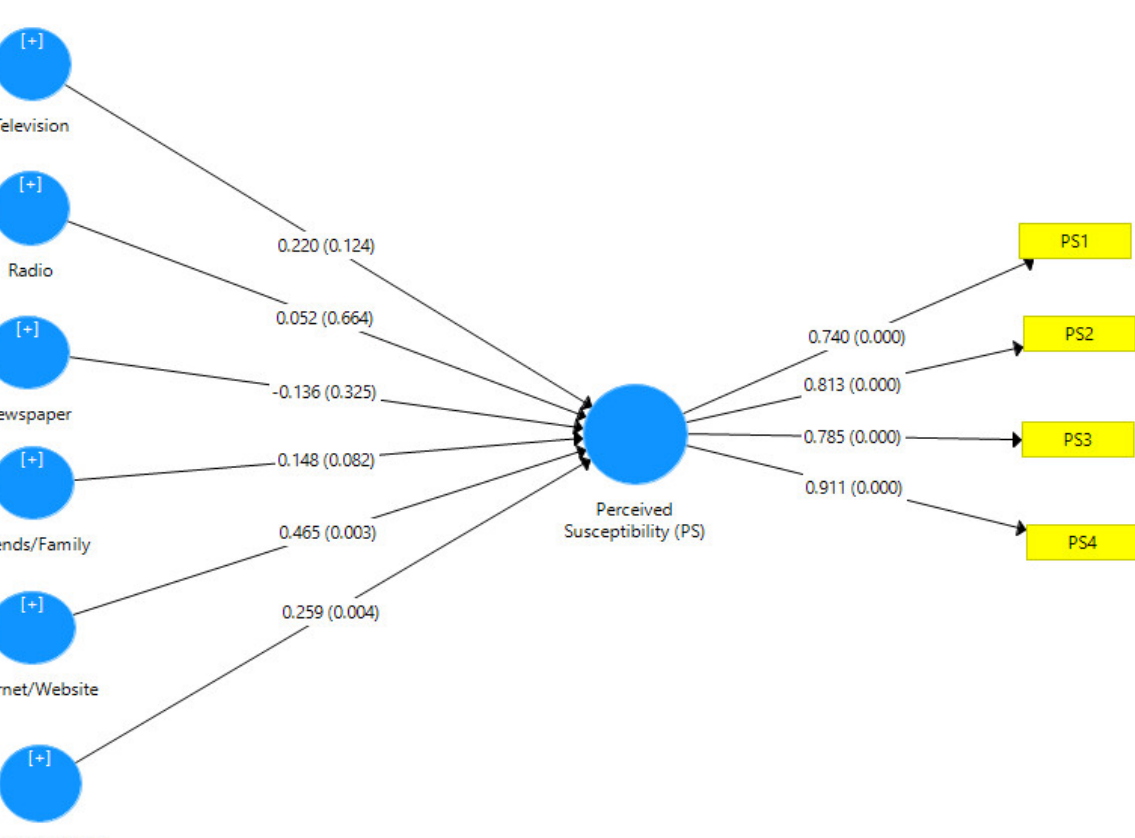
Table 2. Construct validity and reliability for Hypothesis One.